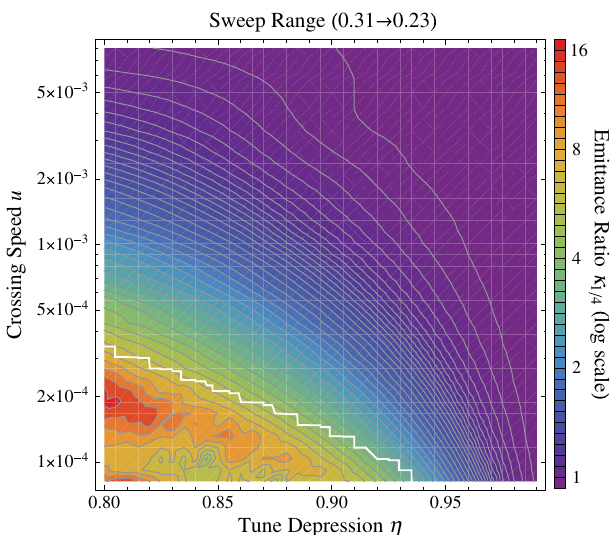
FIG. 17. Contour plot of the emittance growth rate on the (cid:3) - u after the quarter- plane. The final-to-initial emittance ratio (cid:8) 1 = 4 integer resonance crossing is evaluated from systematic WARP simulations and color-coded in (cid:3) - u parameter space. The initial plasma temperature at (cid:5) 0 ¼ 0 : 31 has been set at 0.1 eV in all simulations. The white solid line indicates the border below which finite particle losses occur due to a large emittance growth before (cid:5) 0 reaches the final value